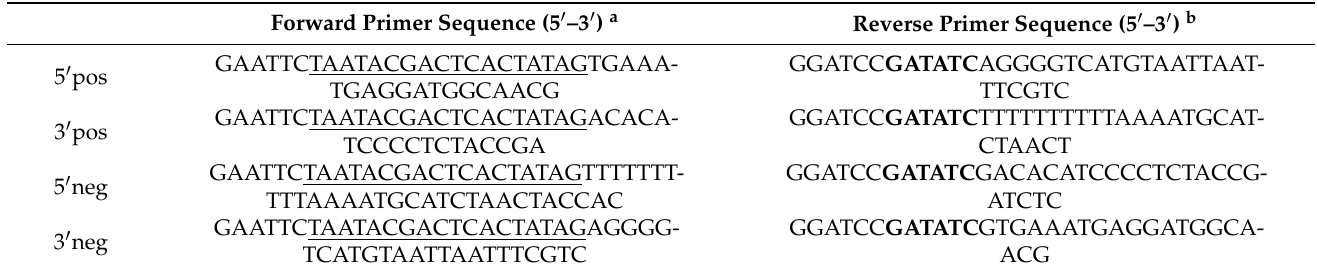
Table 1. Primer sequences for generation of RNA probes corresponding to the viral genome. Forward Primer Sequence (5 (cid:48) –3 (cid:48) )